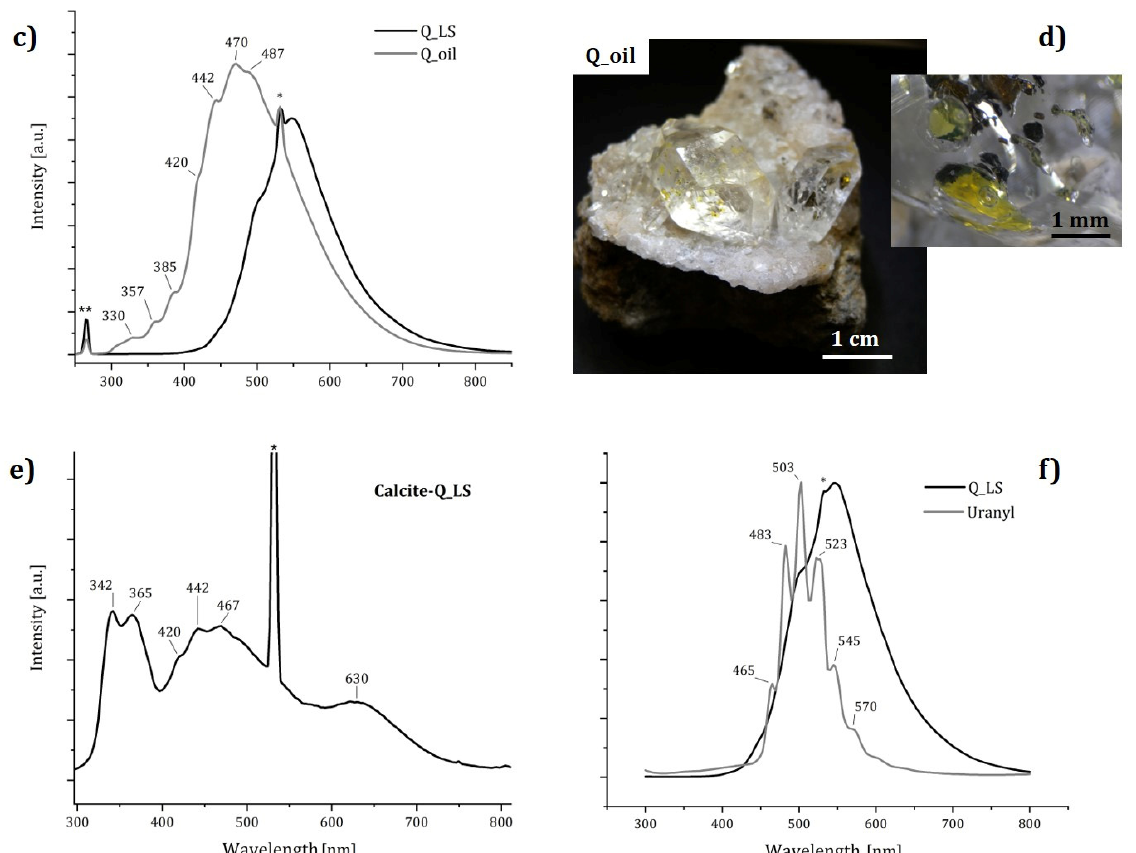
Figure 4. Representative LIF spectra of La Sassa quartz. The asterisk (*) mark in the spectra indicates the second harmonic at 532 nm of the laser ( λ exc = 266 nm). ( a , b ) La Sassa quartz spectrum and its peak fitting; ( c ) comparison between LIF spectrum of Q_LS and Q_oil characterized by visible oil inclusion ( d ); ( e ) LIF spectrum of the calcite where the La Sassa quartz growth as veins; ( f ) comparison of the Q_LS spectrum with uranyl characteristic spectrum obtained by the authors analysing a different kind of calcite, as reported in the literature [48].